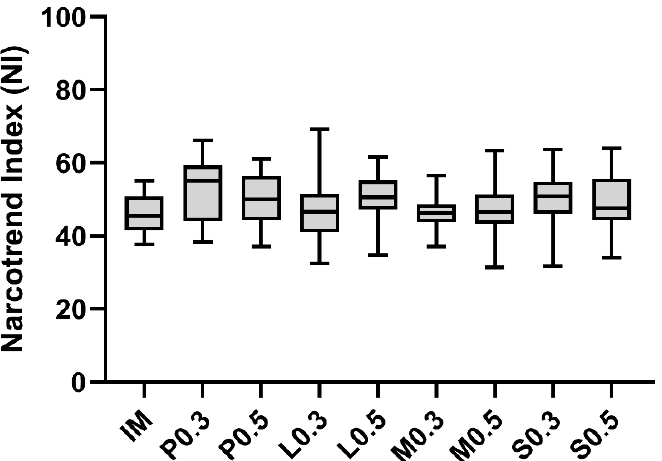
Figure 3. Baseline Narcotrend Index. Baseline before injection of Narcotrend Index (NI) for groups P 0.3 , P 0.5 , L 0.3 , L 0.5 , M 0.3 , M 0.5 , S 0.3 , S 0.5 and IM. The box covers the interquartile interval, where 50% of the data are found. The whiskers indicate minimum and maximum and the band inside the box represents the median.